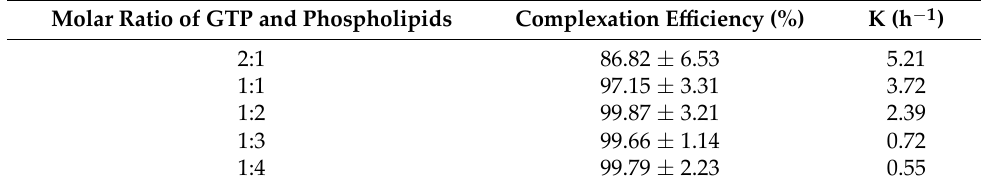
Table 4. Complexation efficiency and dissociation rate of phytosome of different molar ratios of GTP and